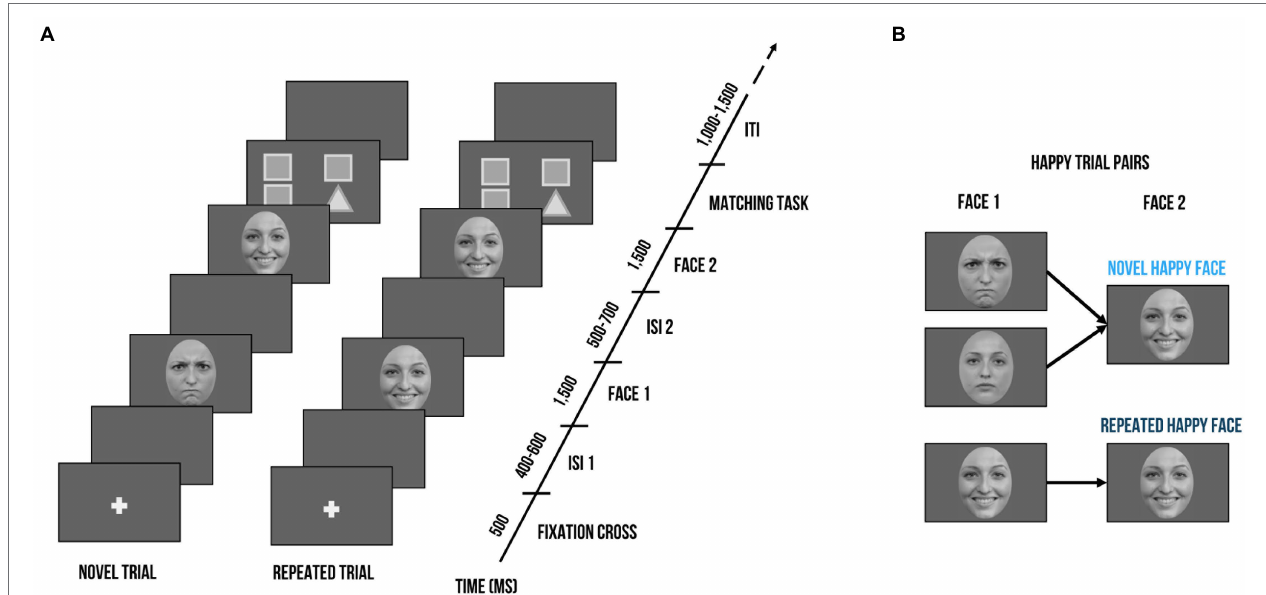
FIGURE 1 | Visualization of the delayed match-to-sample task. (A) Exemplary trial sequence: Each trial included the presentation of a fixation cross (500 ms), followed by a blank screen (400–600 ms), Face 1 (1,500 ms), another blank screen (500–700 ms), and Face 2 (1,500 ms). Face 2 could either bear the same facial expression as Face 1 ( repeated trial ) or a different one ( novel trial ). After seeing Face 2, children had to indicate whether the facial expression of Face 1 and Face 2 were the same; triangles and squares shapes on screen served as reminders of the button order (e.g., two squares on the left side indicated that the left button needed to be pressed when the facial expression of Face 1 and Face 2 was repeated). (B) Exemplary trial pairs for happy expressions. Novel happy face trials started with a neutral or angry expressions at Face 1 and always contained a happy expression at Face 2. Repeated happy face trials consisted of the same happy facial expression at Face 1 and Face 2. Face stimuli are obtained from the Radboud Faces Database (Langner et al., 2010). The depicted individuals provided written informed consent for the publication of their identifiable